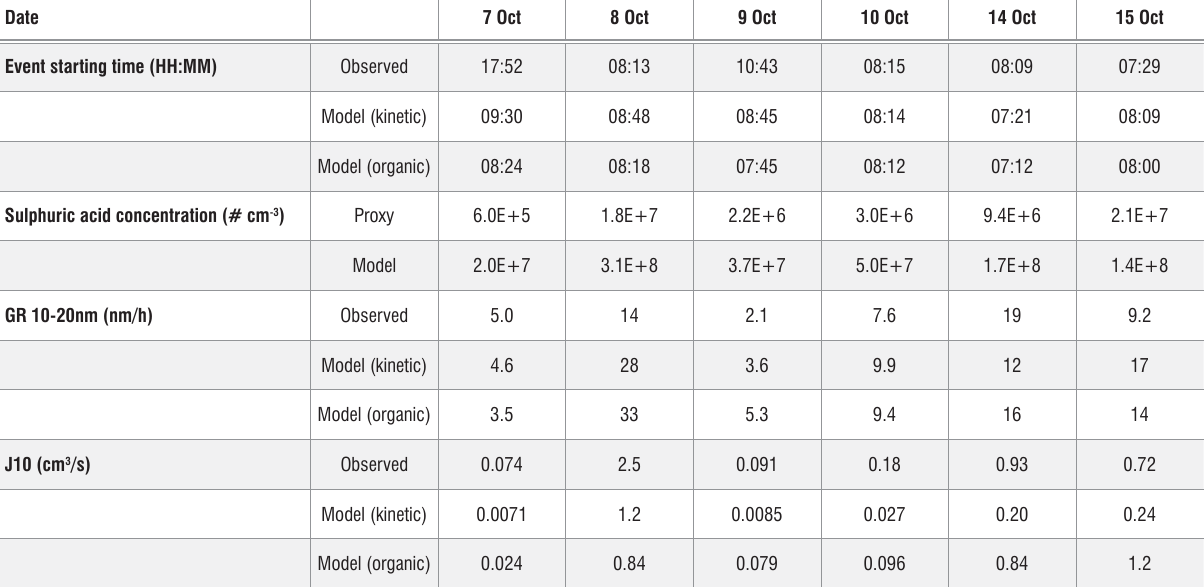
) and sulphuric acid concentrations calculated from measurements, the two different simulations Table 2: Growth rates (GR), particle formation rates (J 10 and for the sulphuric acid proxy. J -values shown are the means over 4 h after the start of the nucleation event. Sulphuric acid concentrations 10 from both the simulation and proxy are given for the time defined by simulation (kinetic nucleation). For completeness, the estimated starting times of the events, defined from J time series, are 10